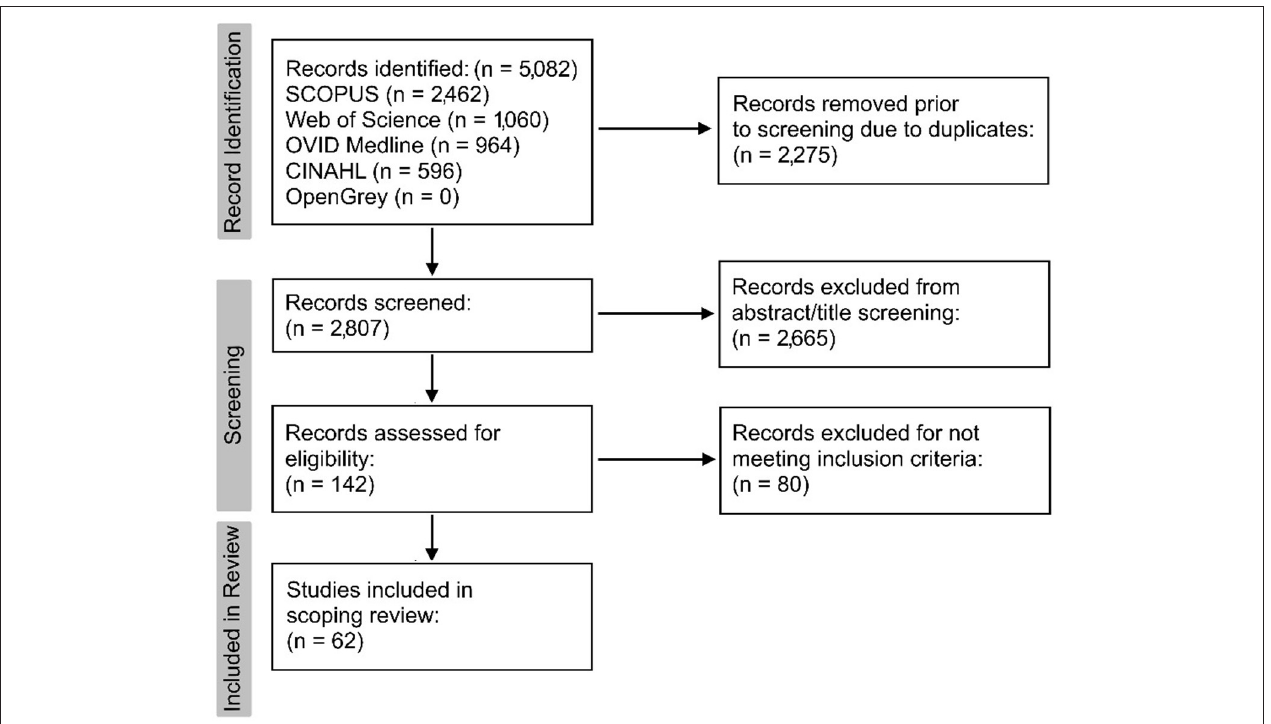
FIGURE 1 | Modified version of the PRISMA 2020 flowchart (9) to summarise record retrieval.